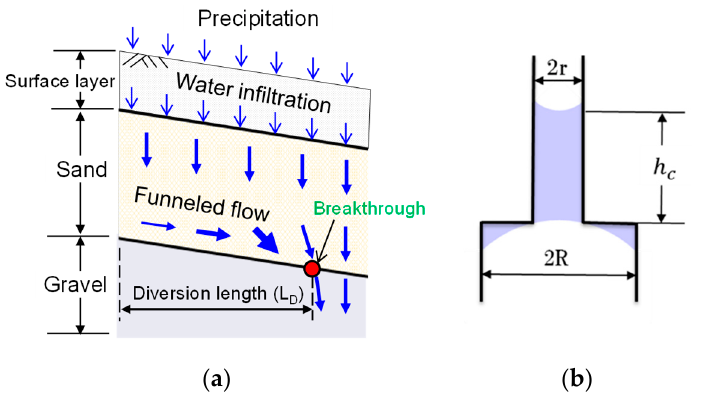
Figure 1. Concept of the CB system and capillary tube model: ( a ) concept of the CB system; ( b ) capillary tube model.